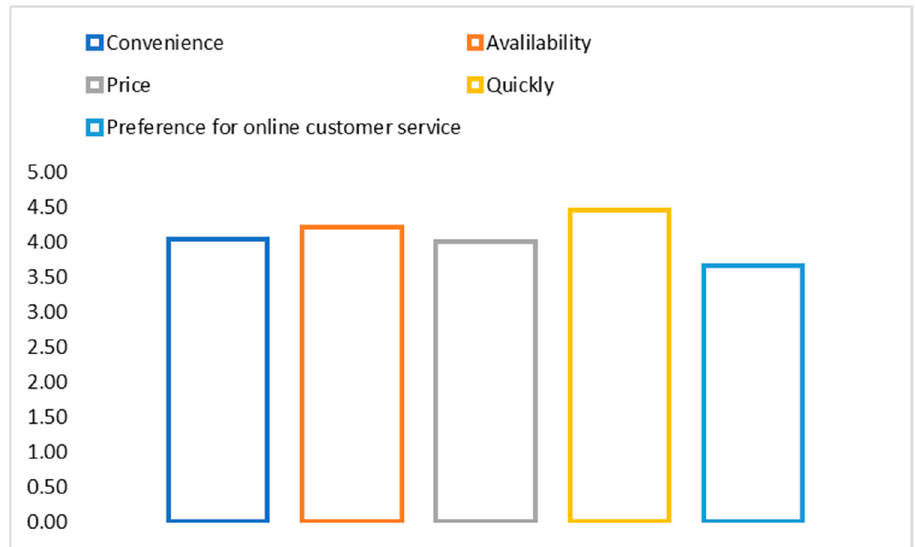
Figure 3. Factors making online shopping a better experience (Likert scale from 1 to 5).